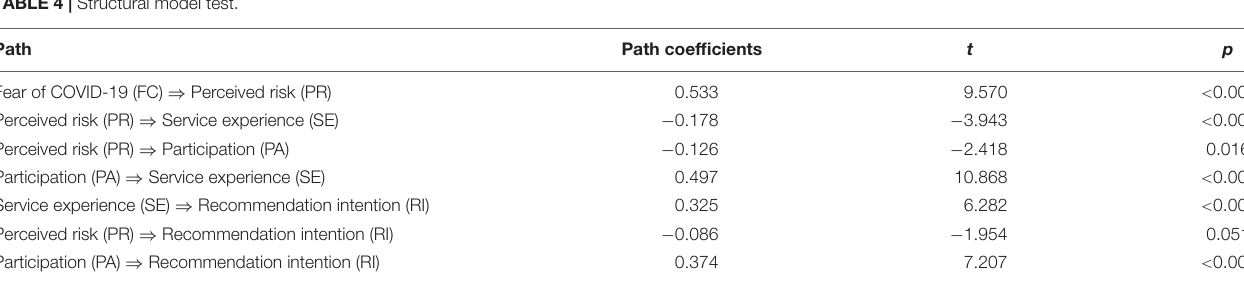
TABLE 4 | Structural model test.